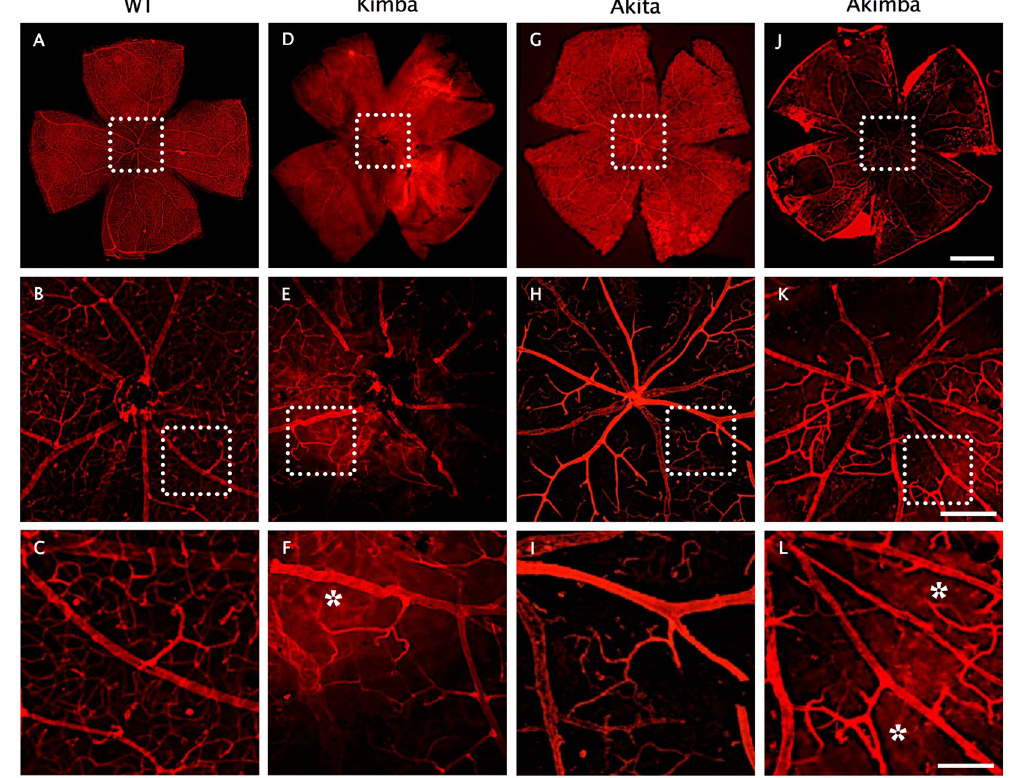
Figure 5. Loss of retinal capillary density and vessel leakage in Akimba mice. Isolectin-GS IB4 staining on retinal flat mount showed normal vascular bed and uniform capillary distribution in WT ( A – C ) mouse, which was reduced markedly in Kimba ( D – F ), Akita ( G – I ) and significantly higher in Akimba ( J – L ) mice. Disruption of the capillary network was noted especially around the optic disk of Akimba ( K ) retina. Diffused staining (asterisk) around the optic head of Kimba ( F ) and Akimba ( L ) mice indicate loss of vessel integrity and leakage. n = 4 retina per group. Each retina flatmount image ( A, D, G , and J ) was stitched from at least 8 images were taken at 50 × magnification; scale bar, 1 mm. Insets shown in middle row ( B, E, H , and I ) were taken at 100 × ; scale bar, 200 µ m. Insets are shown in bottom row ( C, F, I , and L ) were taken at 200 × ; scale bar, 100 µ